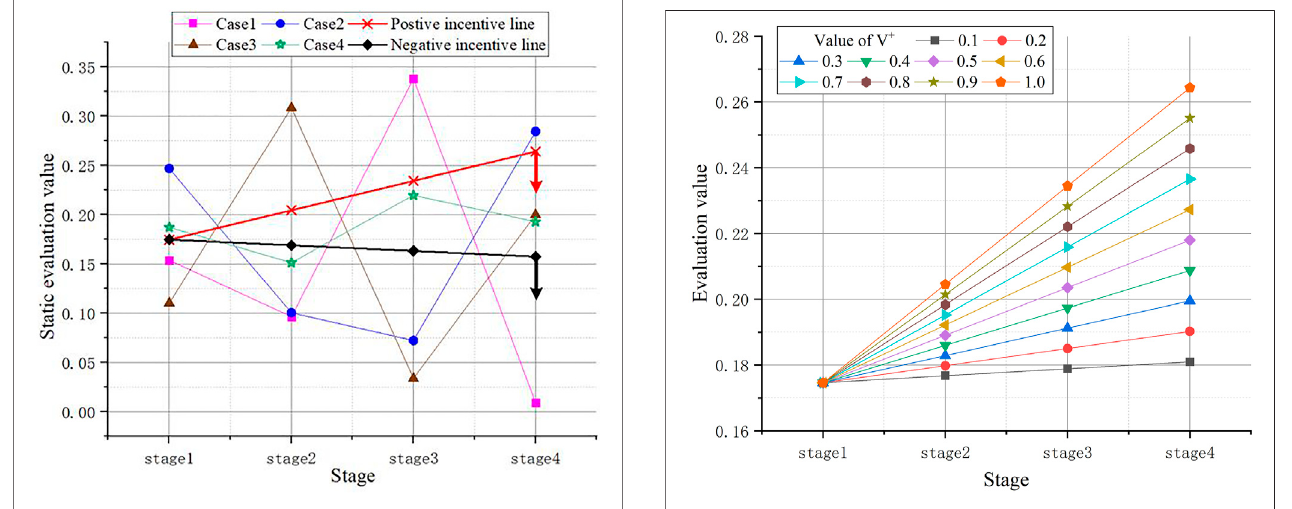
FIGURE 10 | In fl uence of different V + on negative excitation